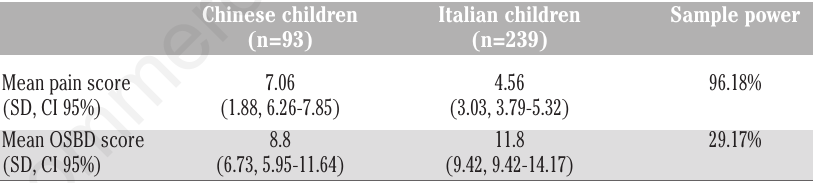
Table 3. Differences in the mean pain and Observational Scale of Behavioral Distress (OSBD) cores of pre-school Chinese and Italian children.